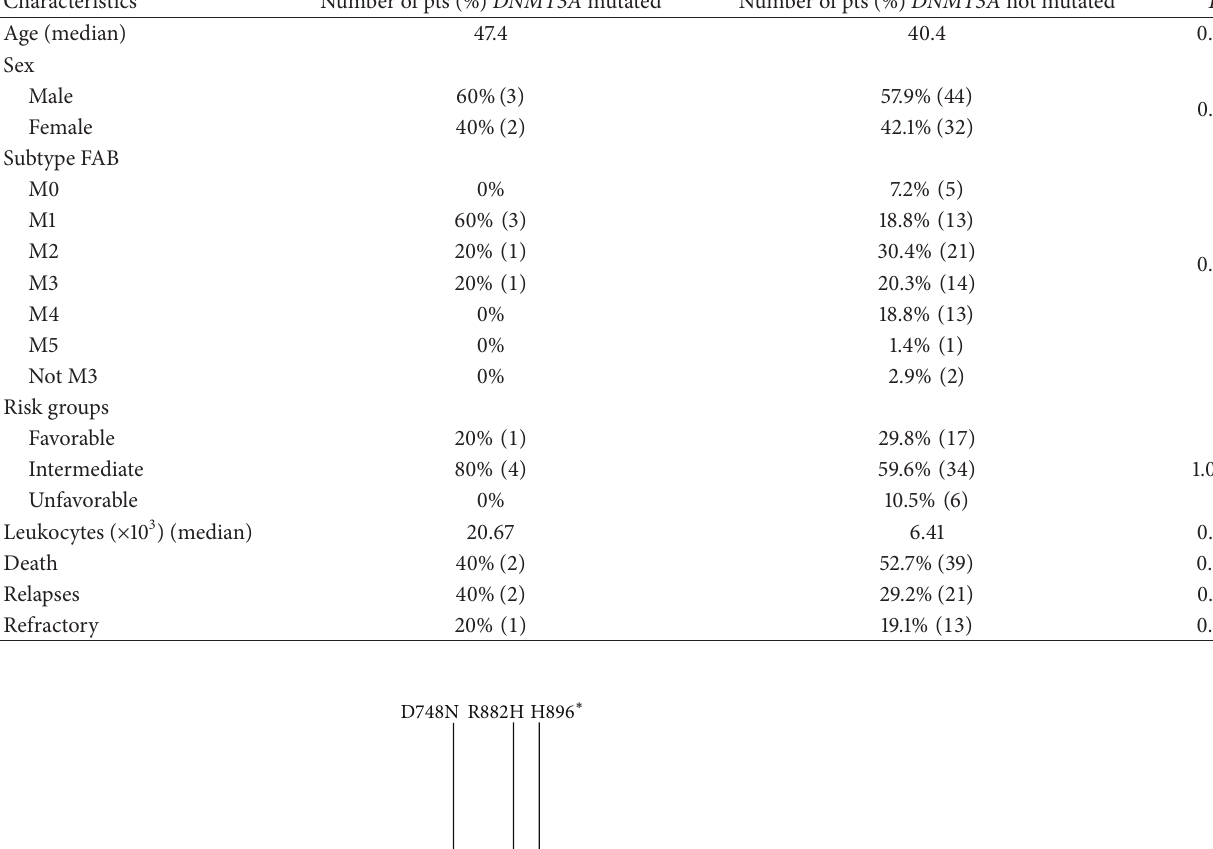
Table 5: Clinical characteristics of patients with Acute Myeloid Leukemia with or without DNMT3A mutations. Characteristics